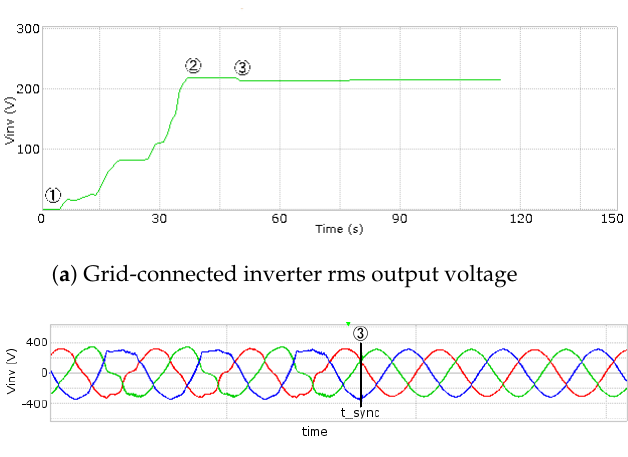
Figure 17. Synchronization sequence on grid-connected inverter: (1) grid-connected inverter is started; (2) phase-adjustment; and (3)